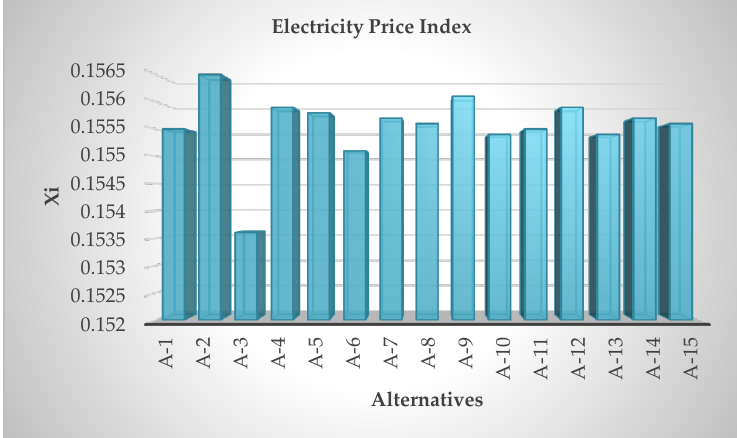
Figure 12. Electricity price index of each alternative.